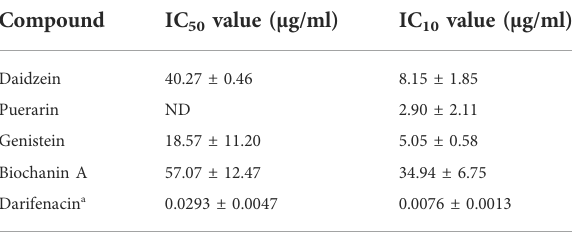
TABLE 1 Inhibition values of active compounds isolated from Gegen waterextractoncarbachol-induceddetrusorcontraction(Mean± SEM, n =